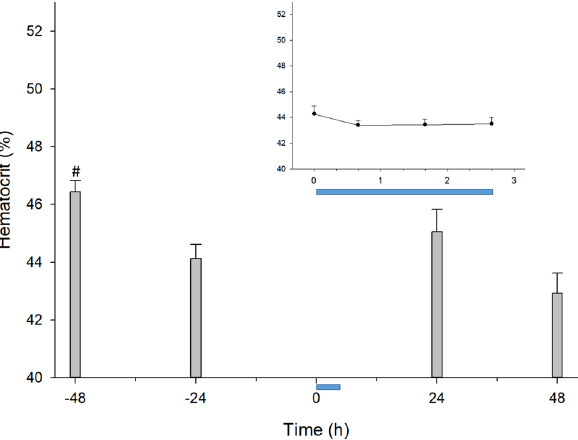
Figure 2. Volemia did not change in response to exercise. #Pre vs . − 48 h: p = .010; effect size = 1.0; statistical power = 0.94. The blue bar represents the CCombat protocol in scale in both graphs. AVG ±